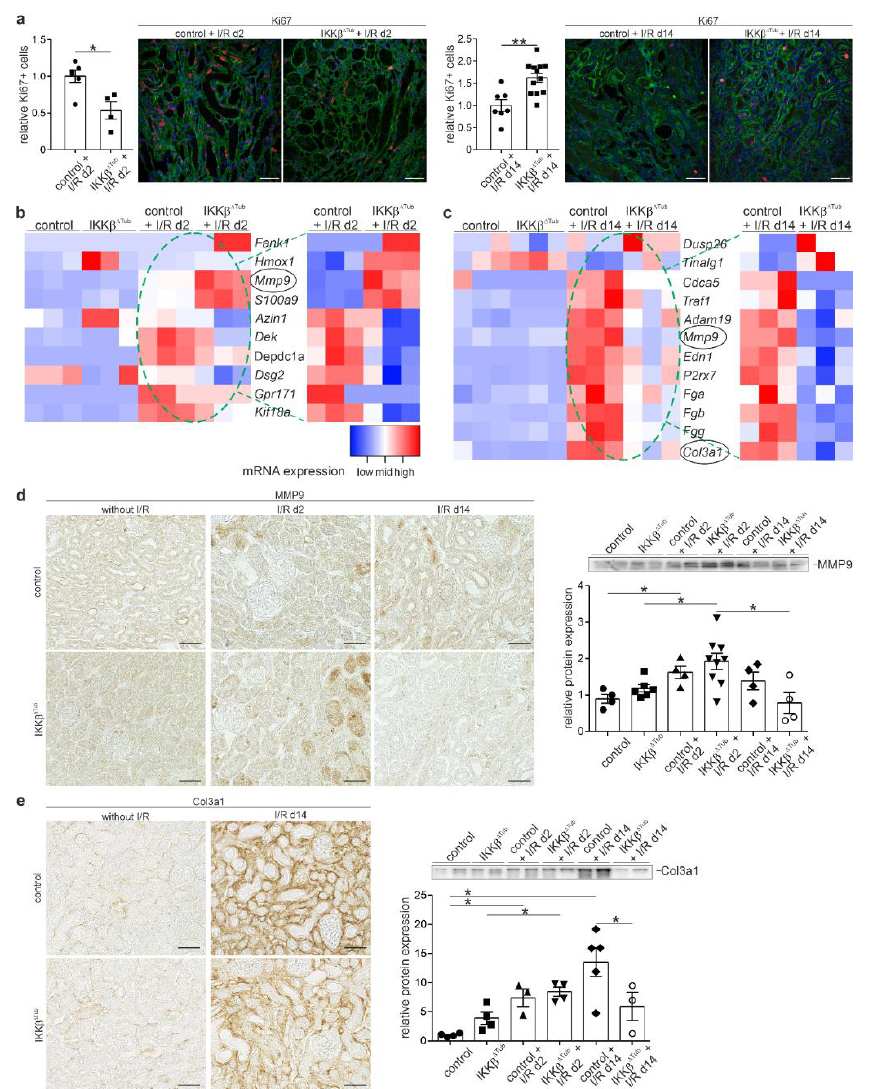
Figure 5. Tubular deletion of IKK β affects proliferation, tissue regeneration and fibrosis. ( a ) assessment of Ki67-positive proliferating cells in control and IKK β ∆ Tub at 2 days and 14 days after I/R injury showing the semi-quantitative evaluation and representative images. Scale bar = 50 µ m. Arithmetic means ± SEM of n = 4–12 per group; ( b , c ) heatmaps of significantly altered mRNA for cell proliferation, apoptosis and fibrosis at 2 days ( b ) and at 14 days ( c ) after I/R injury. Filter criteria were DESeq p -values < 0.05; fold change > 1.5. All heatmaps show samples organized in columns and genes in rows, expression intensities are color-coded. ( d , e ) assessment of MMP9 ( d ) and Col3a1 ( e ) showing densitometric analysis of respective Western blots and representing images for each strain and time point. Scale bar = 50 µ m. Arithmetic means ± SEM of n = 3–9 per group. The green stippled circle indicates mRNA of I/R groups used for relative expression in heatmaps by comparing only control with IKK β ∆ Tub at 2 days ( c ) and 14 days ( d ) after I/R injury. For ( a , d , e ) * p < 0.05, ** p < 0.01, Mann–Whitney–U test (if n < 4 Lord